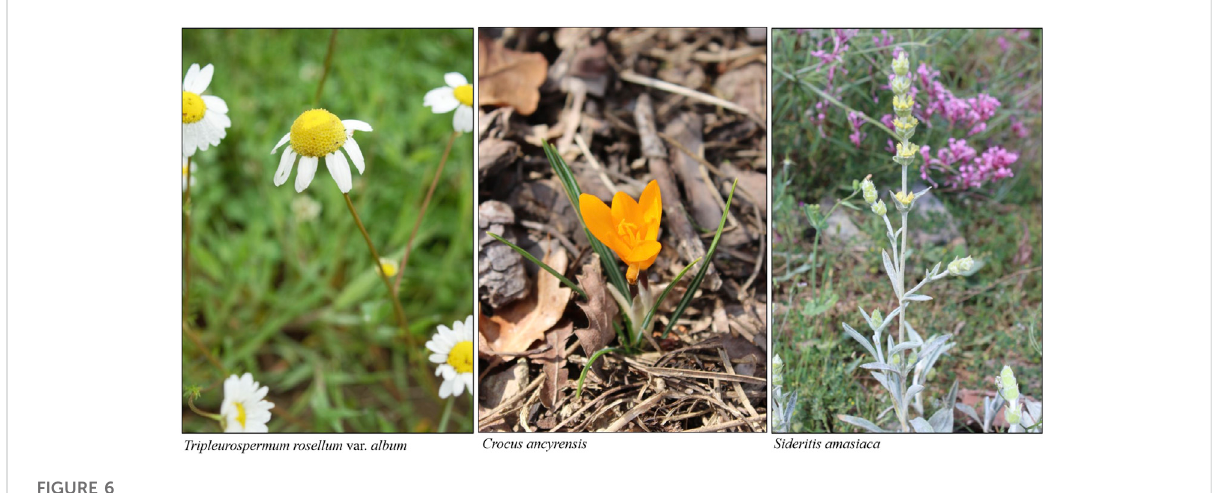
FIGURE 6 A view of the endemics in the research area.